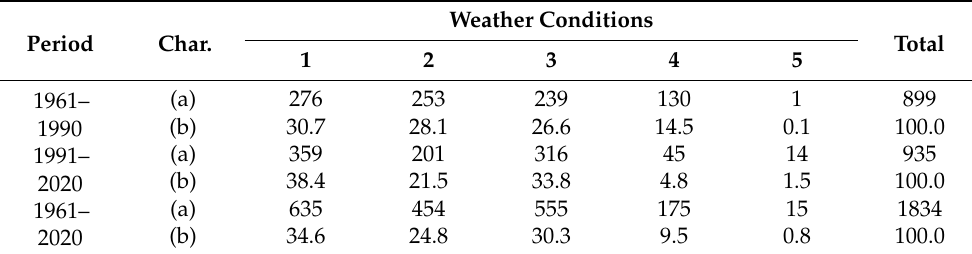
Table 2. (a) Numbers of vehicle accident fatalities associated with inclement weather (1—rain and wet roads, 2—snow (snowfall), 3—glaze ice, 4—fog, 5—other inclement weather), and (b) their proportions to all related fatalities (%) in the Czech Republic in the 1961–1990, 1991–2020 and 1961–2020 periods. Period